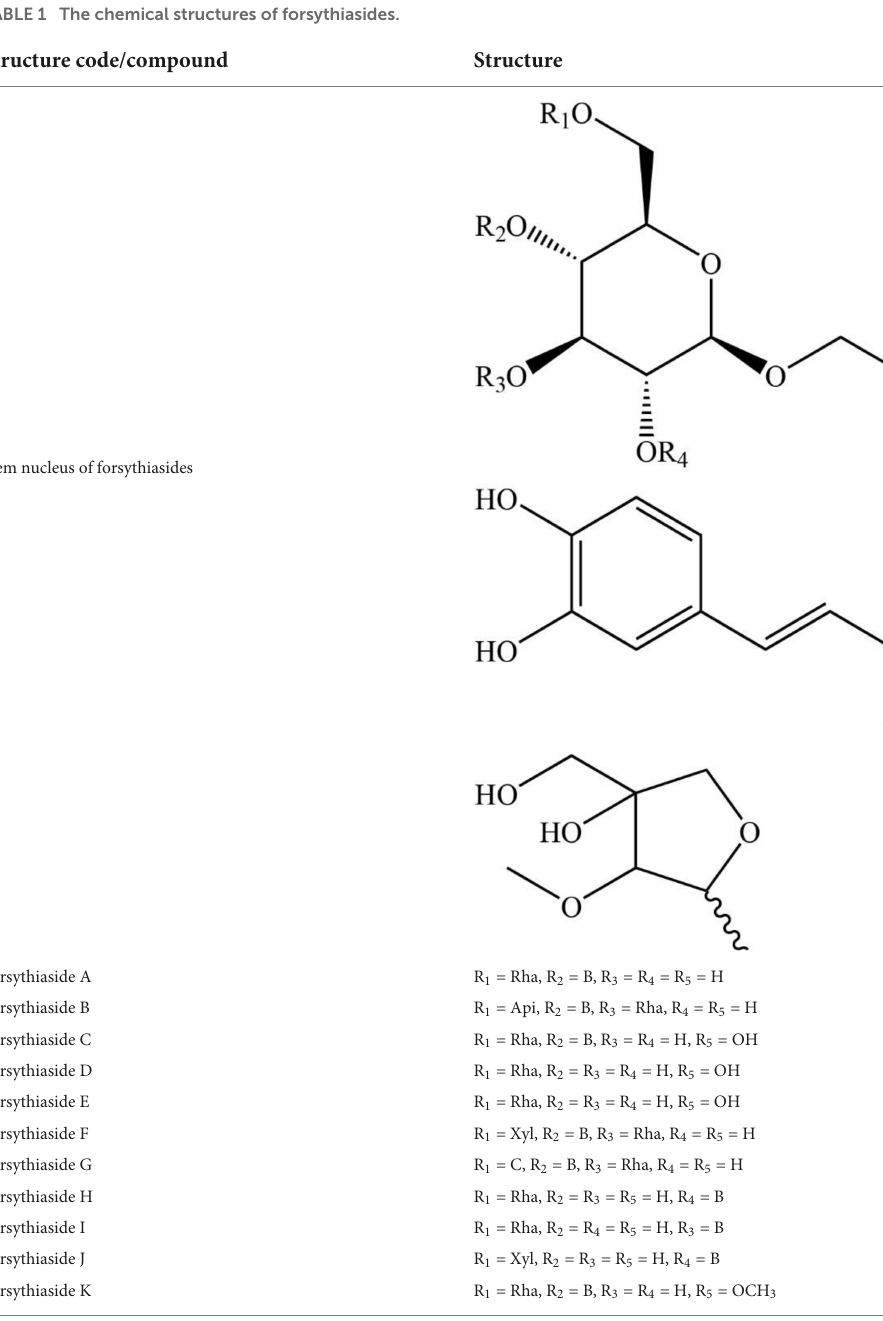
TABLE 1 The chemical structures of